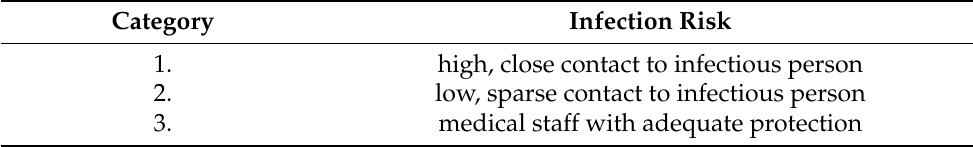
Table 1. Contact categories defined by the